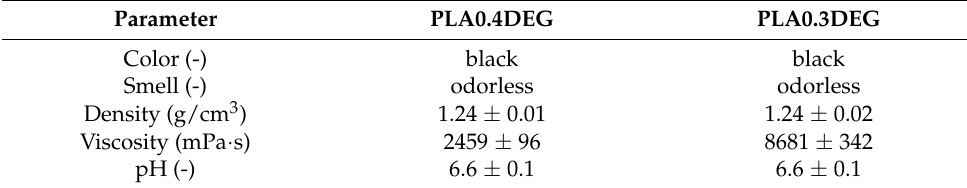
Table 1. Physicochemical properties of new eco-polyols based on waste